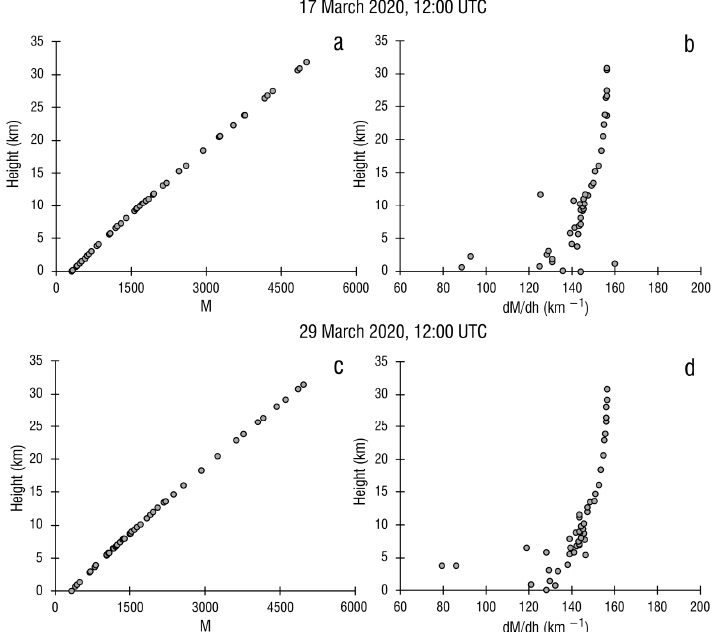
Figure 2. Tropospheric refractive conditions during aerological probing over Zagreb, Croatia, nearest in time to the acquisition of the Sentinel-1A pair of images: ( a ) vertical profile of the modified refraction index on 17 March 2020, 12:00 UTC; ( b ) vertical profile of the modified refraction index gradient on 17 March 2020, 12:00 UTC; ( c ) vertical profile of the modified refractive index on 29 March 2020 at 12:00 UTC; ( d ) vertical profile of the modified refraction index gradient on 29 March 2020, 12:00 UTC.